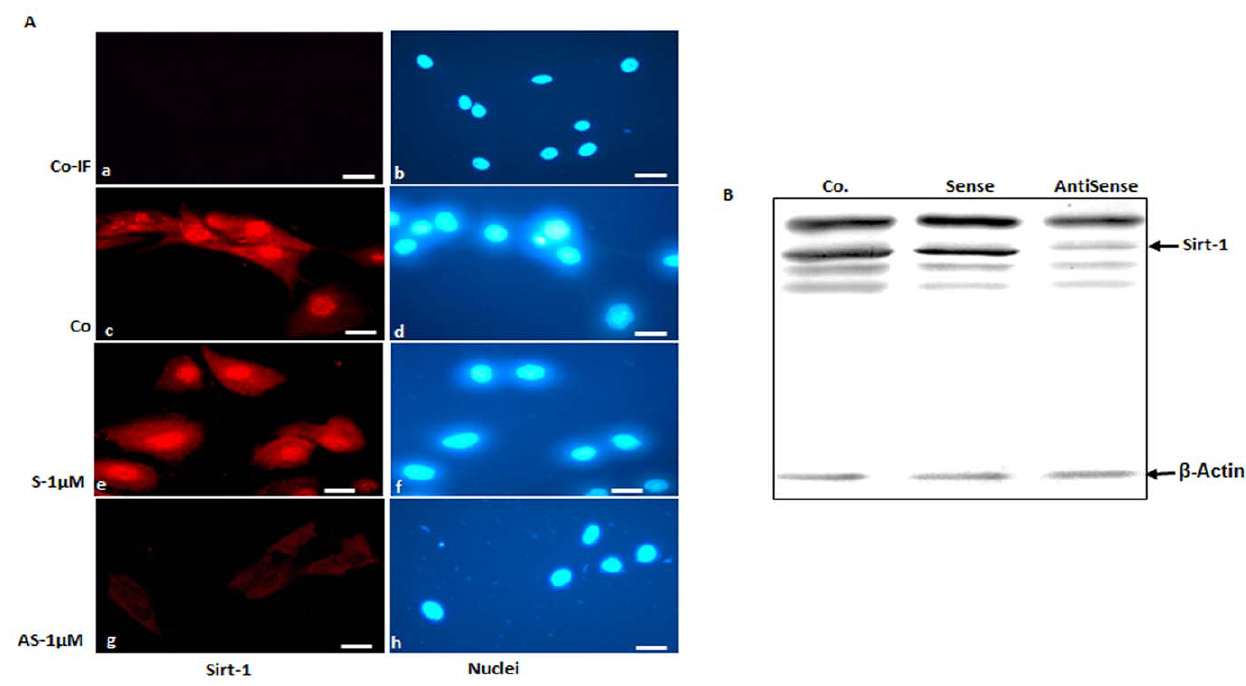
Figure 7. Specific antisense oligonucleotides against Sirt-1 in MSCs lead to decreased Sirt-1 expression in monolayer culture as revealed by immunofluorescence microscopy. A: Mesenchymal stem cells either served as controls (not treated, without primary antibody, a–b; not treated, with primary antibody, c–d) or were transfected with sense (e–f) or antisense (g–h) with 1 m M in the presence of lipofectin for 24 h and resistant colonies were collected. The collected MSCs were subjected to immunolabeling with Sirt-1 antibodies and rhodamine-coupled secondary antibodies. Counterstaining was performed with DAPI to visualize the cell nuclei. It shows that Sirt-1 antisense but not control sense knocks down Sirt-1 protein levels in the nuclei of cells as visualized using an epifluorescence microscope. Images shown are representative of three independent experiments. 6 160. B: cell extracts generated from the cells in A were used for immunoblotting assay with Sirt-1 or b -actin (loading control) antibodies. The immunoblot shown is representative of three independent